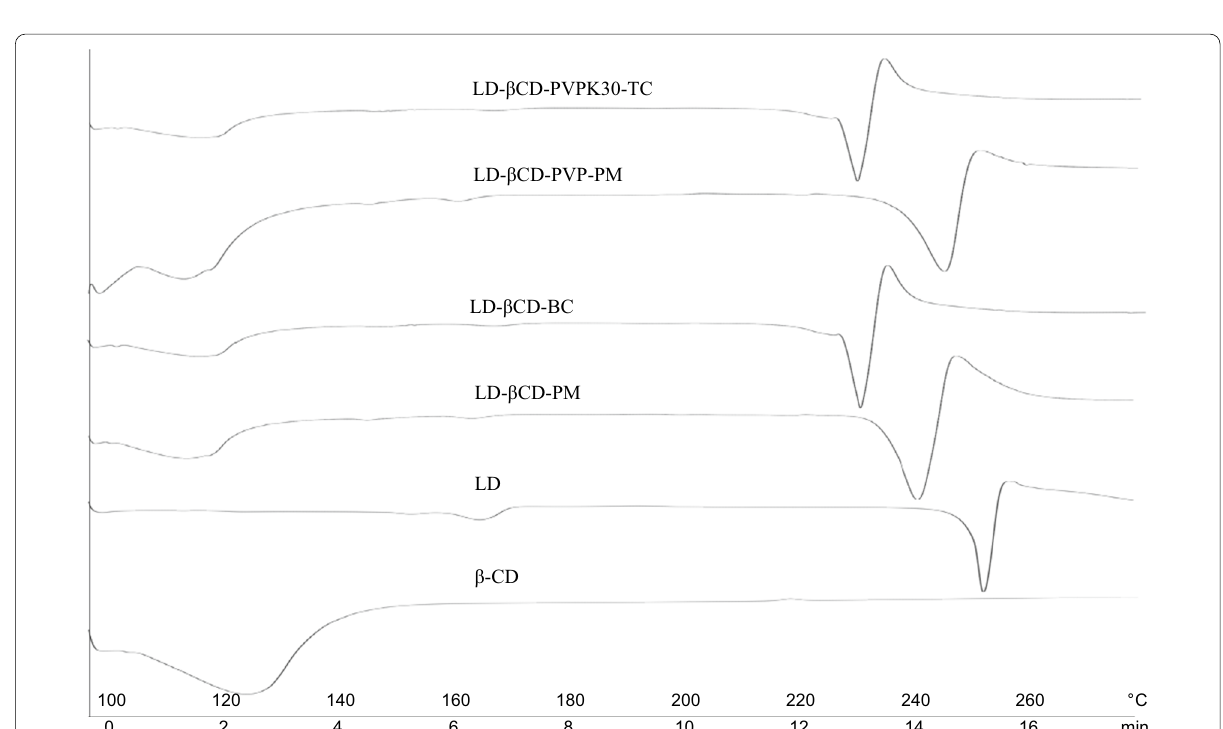
Fig. 7 DSC thermograms of β-CD, LD, physical mixture of LD-βCD, binary complex (LD-βCD-BC), physical mixture of LD-βCD-PVPK30 and ternary complex